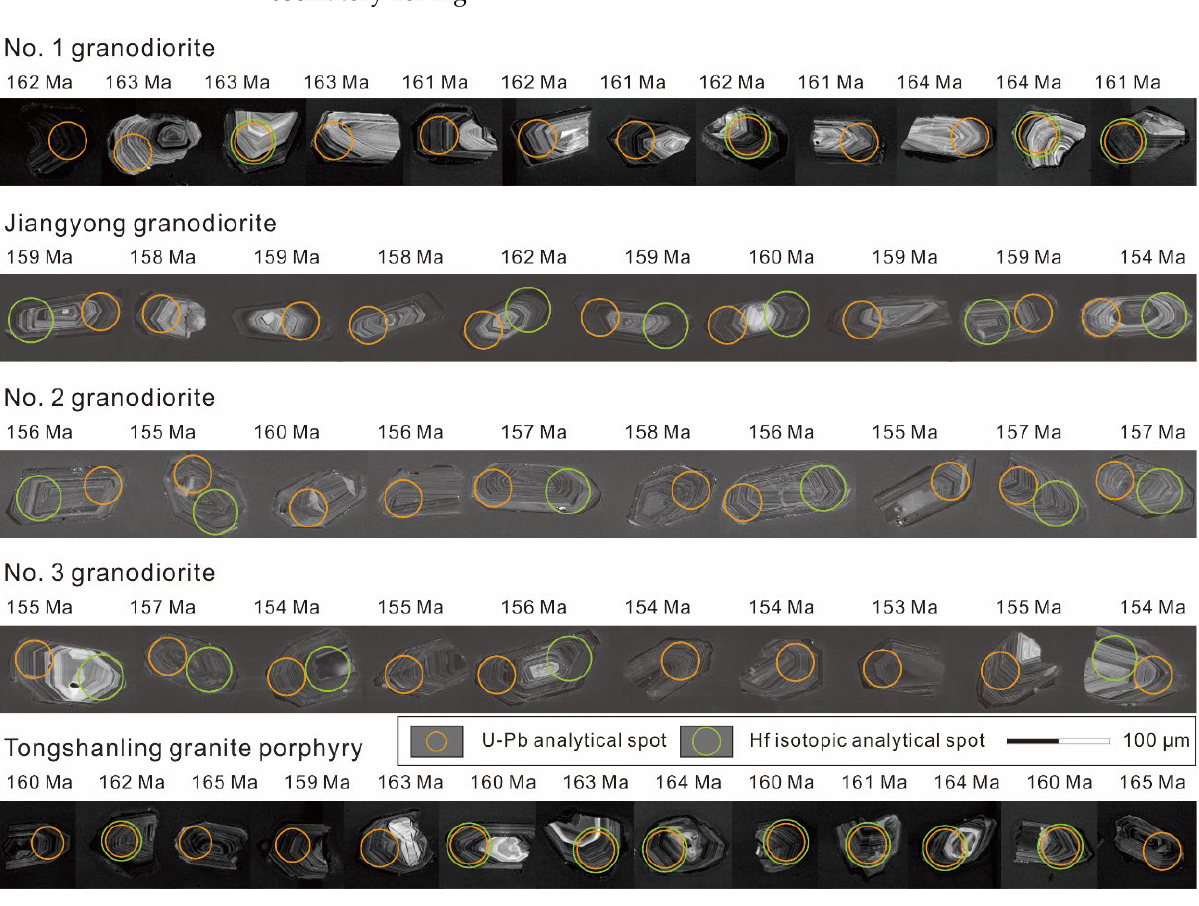
Figure 6. Cathodoluminescence (CL) images of representative zircon grains from No. 1, Jiangyong, No. 2, and No. 3 granodiorites, and granite porphyry in the Tongshanling ore field. The LA-ICP-MS analytical results for U–Pb dating of zircons in the granitoids are shown in Supplementary Table S3. A concordia age of 163.7 ± 0.4 Ma (MSWD = 0.8, Figure 7a) was obtained for 14 zircon grains, which is the best estimate for the crystallization age of No. 1 granodiorite. An analysis of 19 zircon grains from Jiangyong granodiorite yields a 206 Pb/ 238 U concordia age of 159.4 ± 0.6 Ma (MSWD = 0.26, Figure 7b). The 206 Pb/ 238 U ages of 16 zircon grains from No. 2 granodiorite plot on or close to the concordia curve with a 206 Pb/ 238 U concordia age of 157.8 ± 0.6 Ma (MSWD = 0.2, Figure 7c). A total of 20 zircons yielded a concordia age of 154.7 ± 0.6 Ma (MSWD = 0.07, Figure 7d), indicating that the crystallization ages of the samples from No. 3 granodiorite are about 155 Ma. There are some differences in the 206 Pb/ 238 U age of granodiorite and granite porphyry. In total, 17 zircon grains yielded a 206 Pb/ 238 U concordia age of 161.1 ± 0.3 Ma (MSWD = 1.9, Figure 7e), representing the crystallization age of the granite